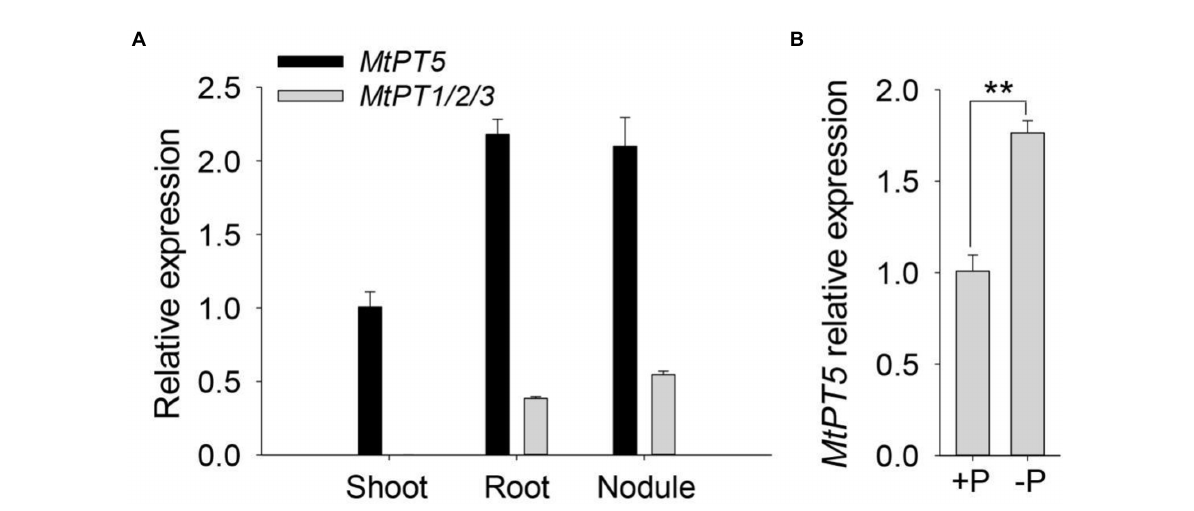
FIGURE 2 Expression profiles of MtPTs in M. truncatula . (A) qRT-PCR analysis of MtPT1 /2/3 and MtPT5 in different tissues of M. truncatula. Four-day-old wild- type seedlings (R108) were incubated with Sm1021 resuspended in 1/2 Hoagland and then transferred to soil and injected with Sm1021 every 2 days for 1 month. Shoots, roots, and nodules were harvested, respectively, for RNA extraction. Data represent mean ± SE ( n = 3). (B) qRT-PCR analysis of MtPT5 in wild-type seedlings (R108) during phosphate starvation. Four-day-old M. truncatula seedlings were transferred to hydroponic solution with Pi (+P) or solution without Pi ( − P) for 5 days. The whole seedlings were used for RNA extraction. Data represent mean ± SE ( n = 3). ** indicates significant difference at p < 0.01 (Student’s t